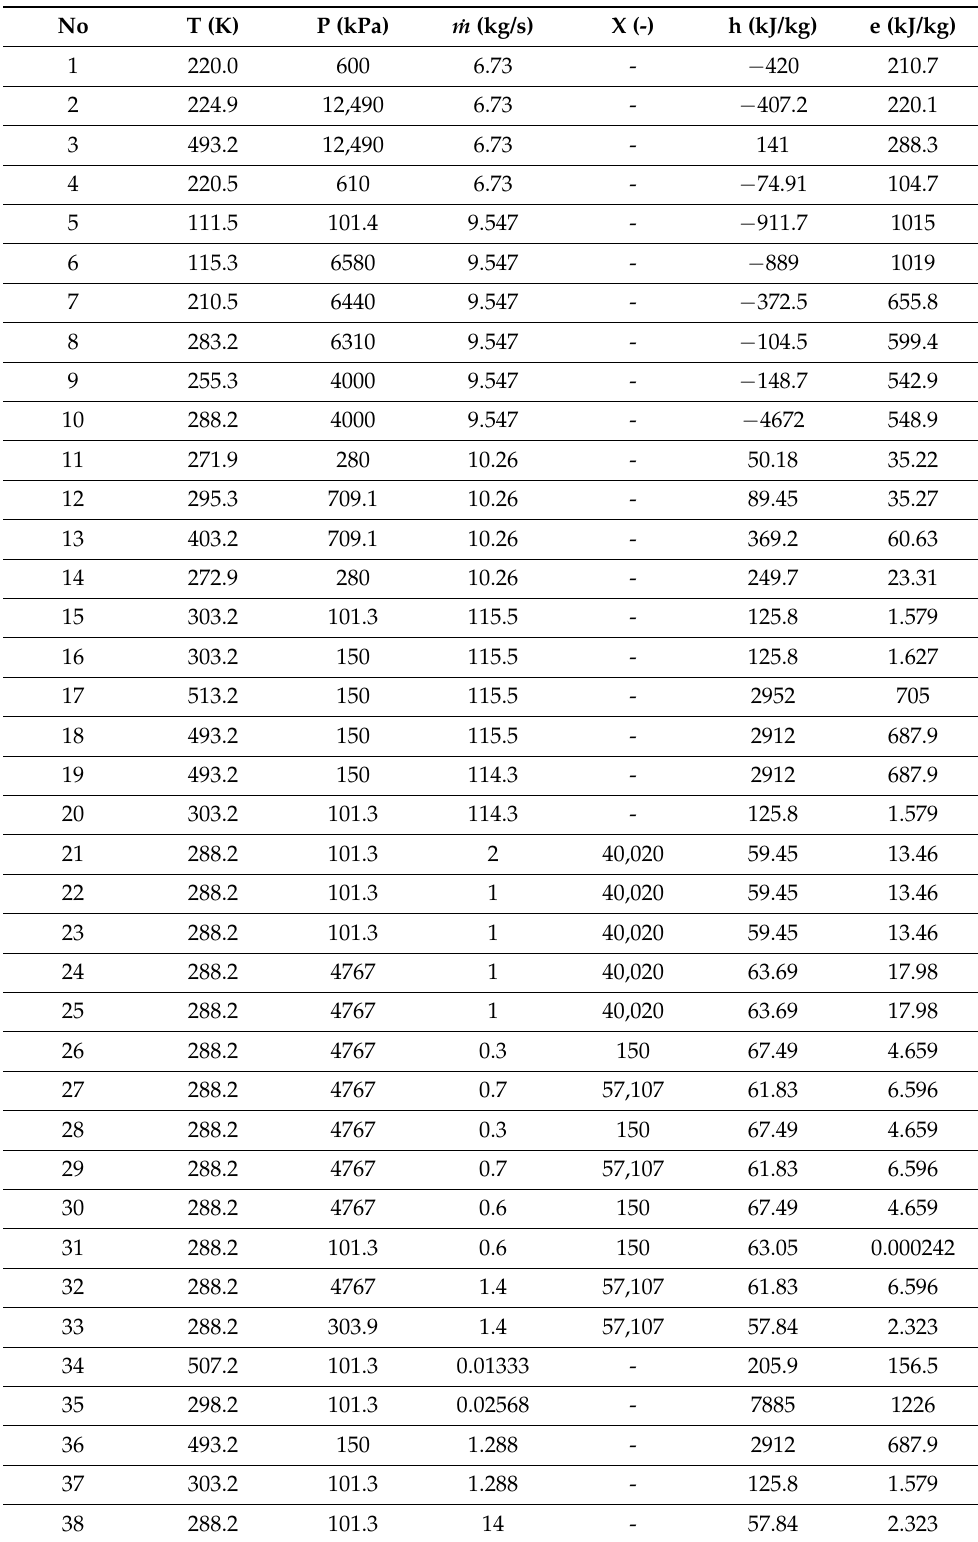
Table 12. The thermodynamic properties at every point of the